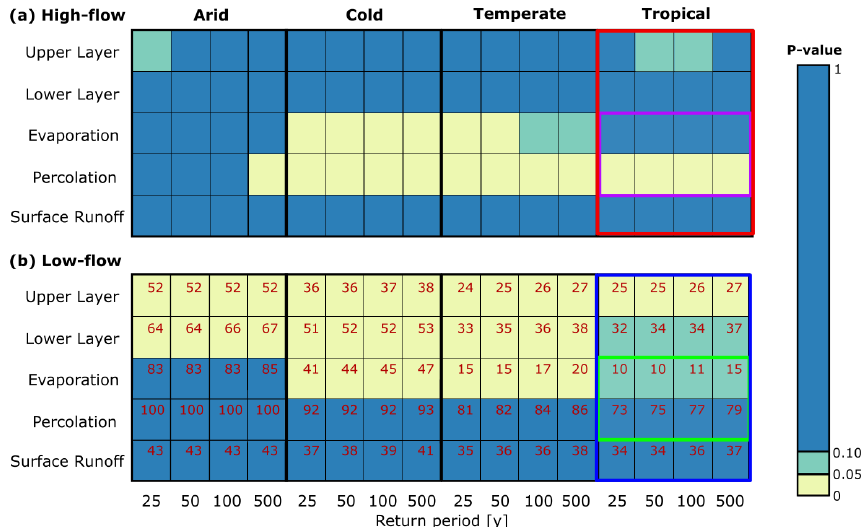
Figure 6. Statistically significant ( p ≤ 0 . 05) and non-significant ( p > 0 . 05) differences between the distribution of magnitudes for extreme runoff events, assessed by a two-sample t test. The colours indicate whether an alteration in the model structure has a statistically significant impact on the magnitude of extreme high- (a) and low-flow (b) events. This is shown for the four climate zones (arid, cold, temperate and tropical, indicated at the top) and the four different return periods (25, 50, 100 and 500 years). The red values in panel (b) indicate the percentage of simulations which reached zero runoff conditions (dry river). The coloured boxes refer to the results displayed in the panels of Fig.